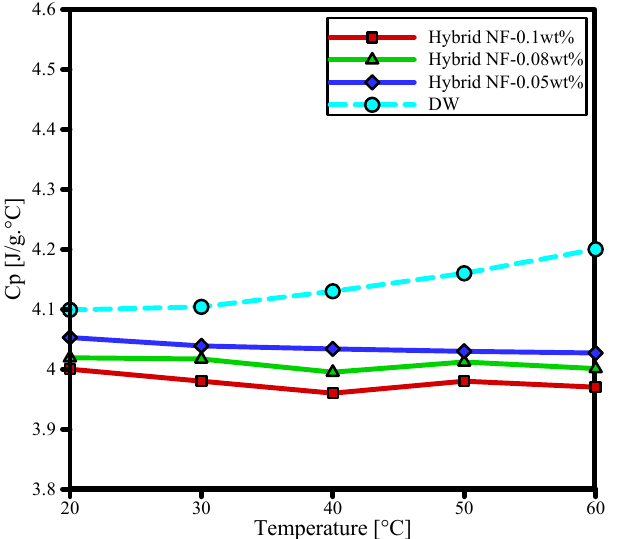
Figure 9. Specific heat capacity with different temperature of water-based hBN/CF-CNTs nanofluid at variance concentration.